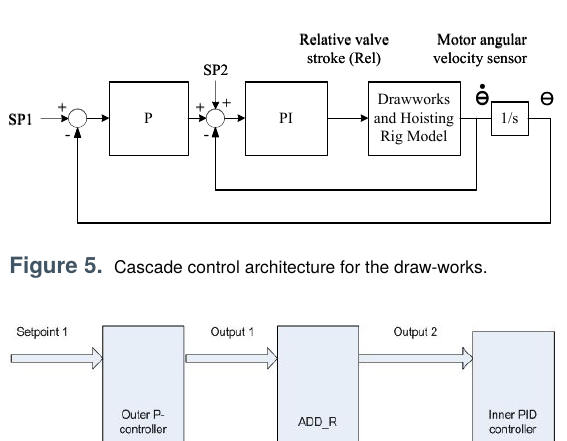
Fig. 8 Coupling properties Figure 8. Coupling